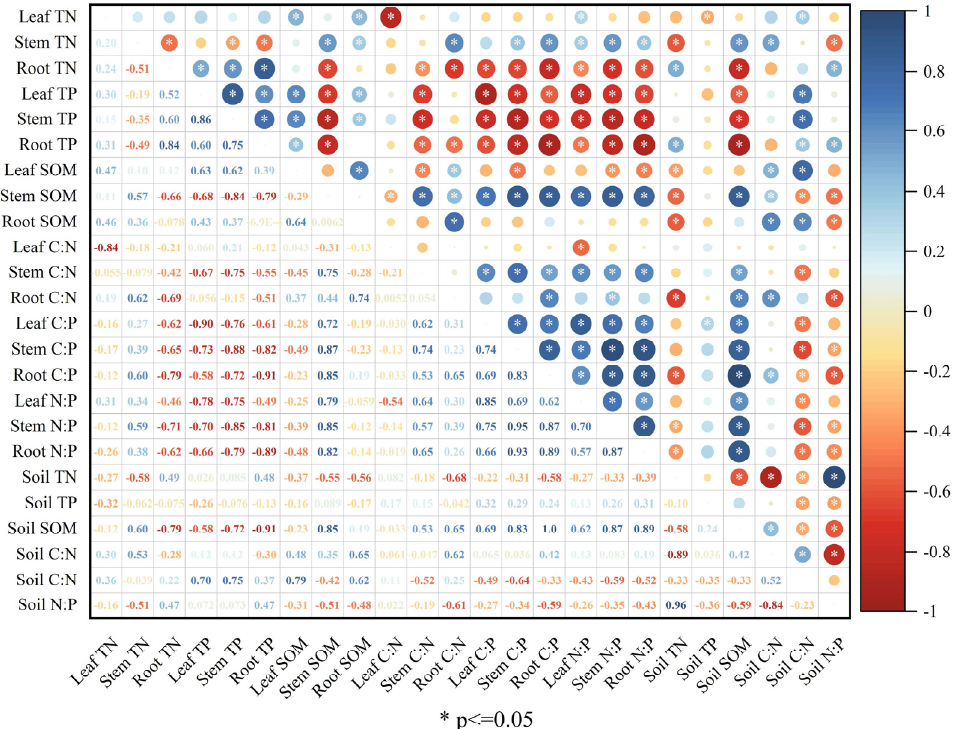
Figure 4. Spearman analysis of nutrition and stoichiometry of C. migao seedlings and soil in the PS